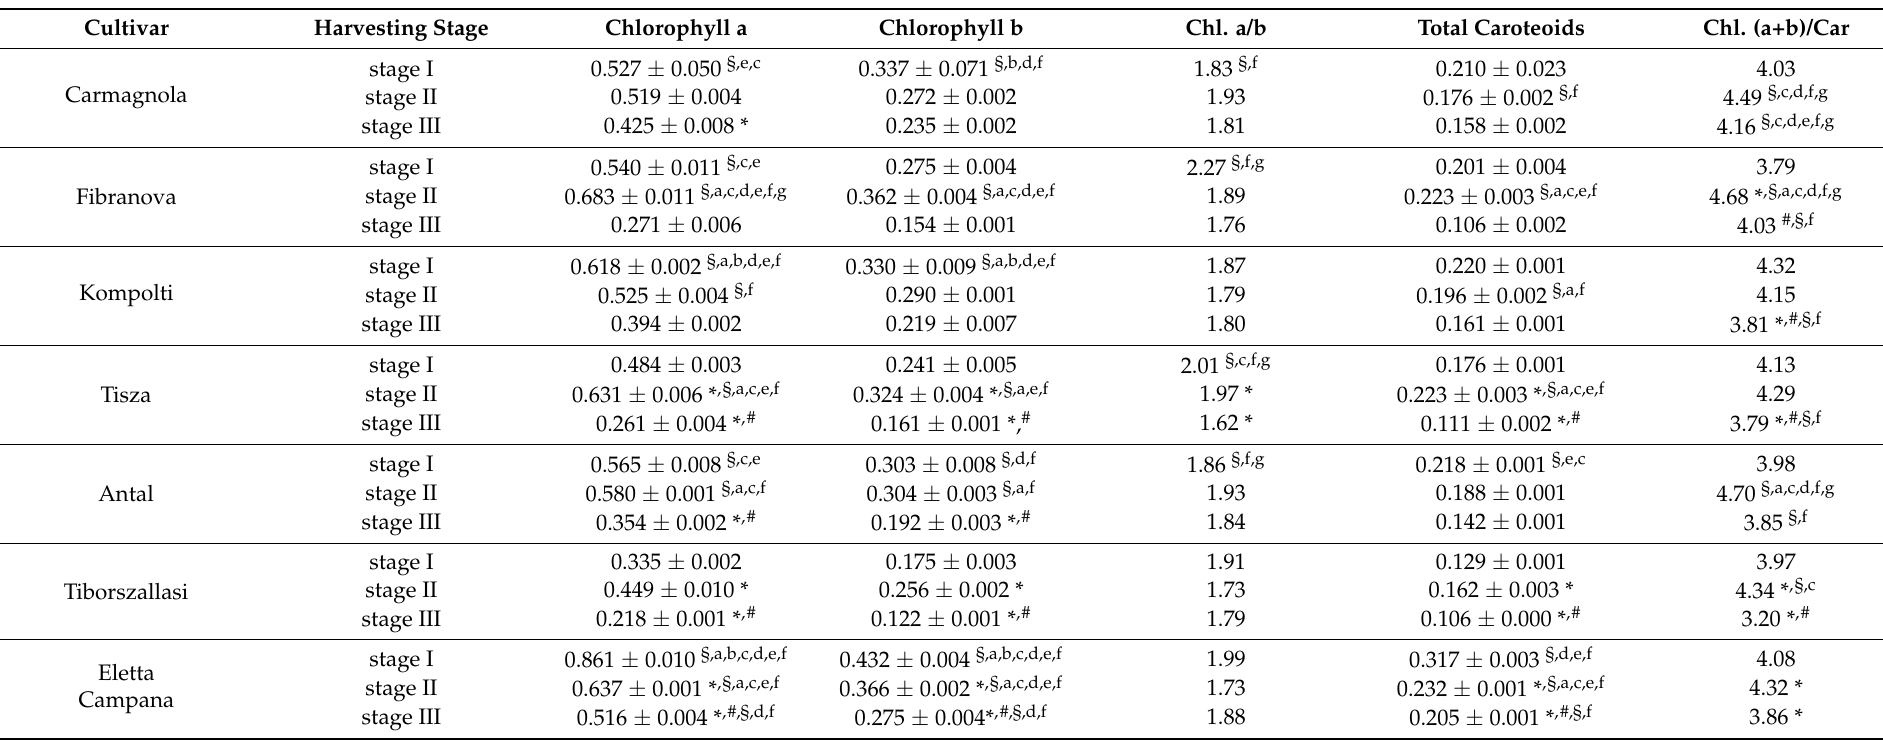
Table 2. Chlorophyll a, chlorophyll b, and total carotenoid concentrations by spectrophotometric analysis (mg/g of fresh inflorescences ± SD) reported for each cultivar at three harvesting stages (stage I = 4 September, stage II = 14 September, stage III = 30 September). Chl a/b and Chl (a+b)/car ratios are also reported. Analyses were carried out in